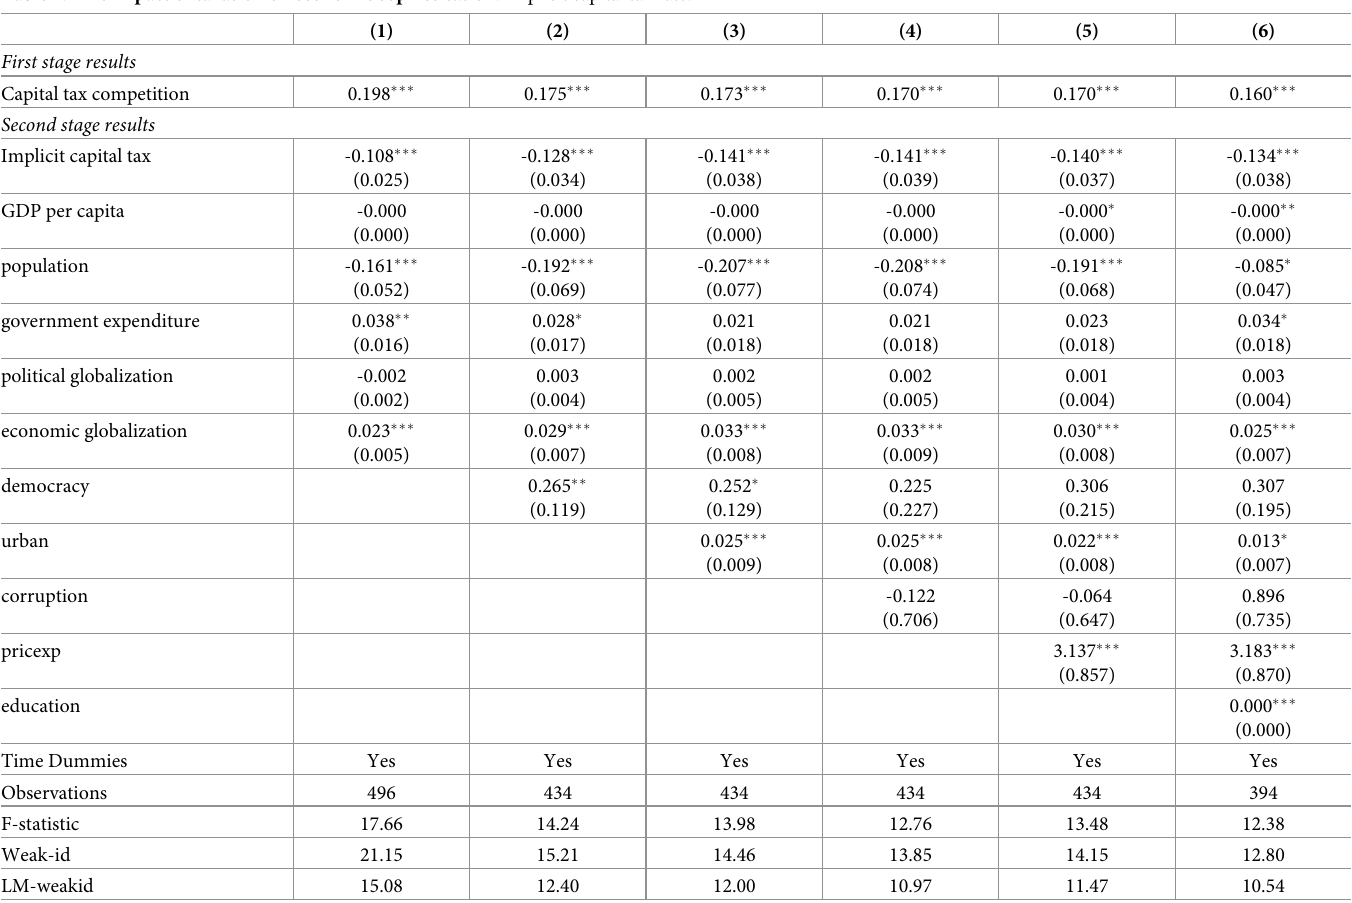
Table 4. The impact of taxation on economic sophistication: Implicit capital tax